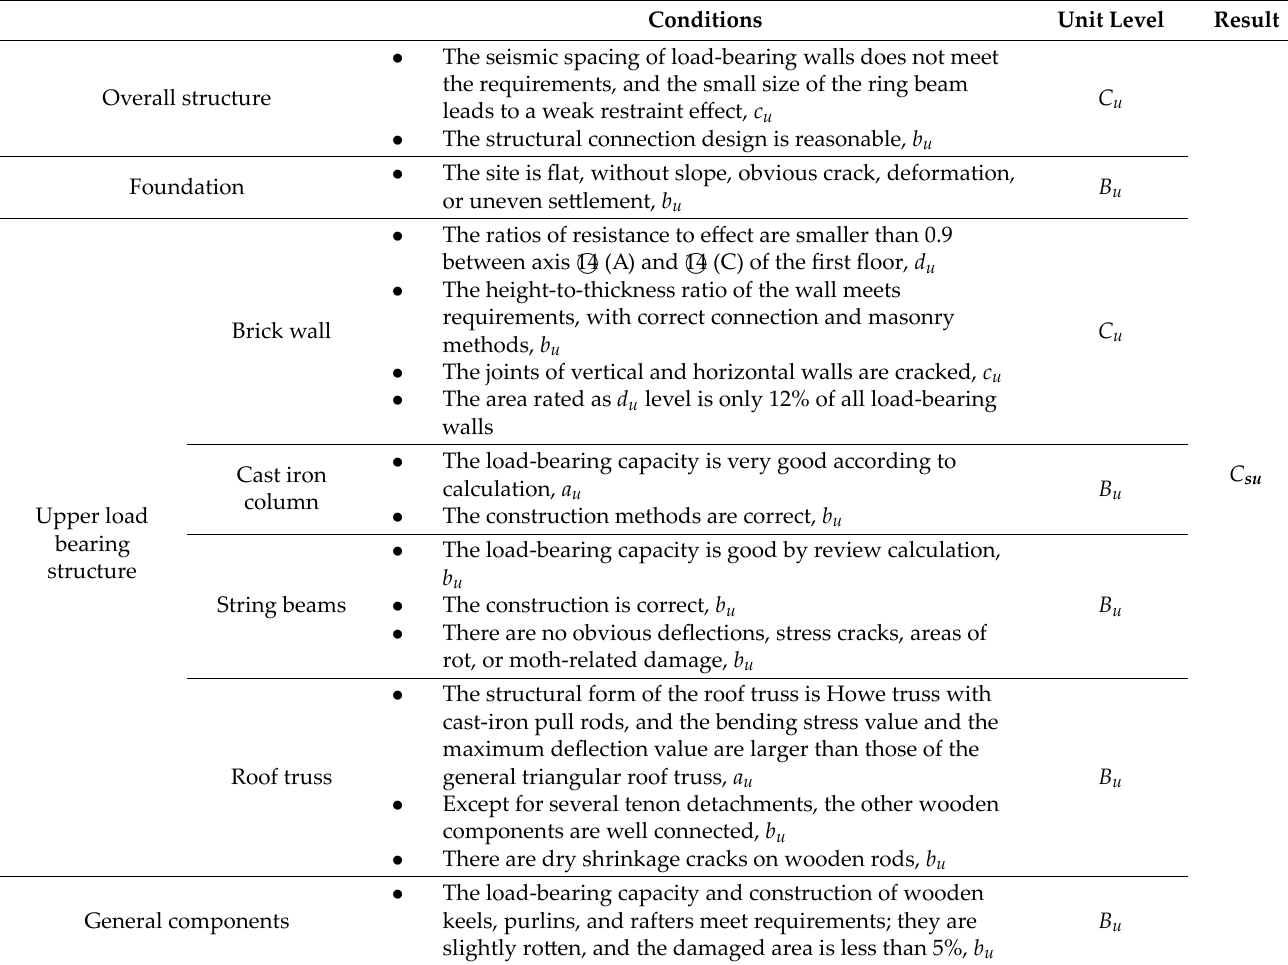
Table 3. Assessment and results of each